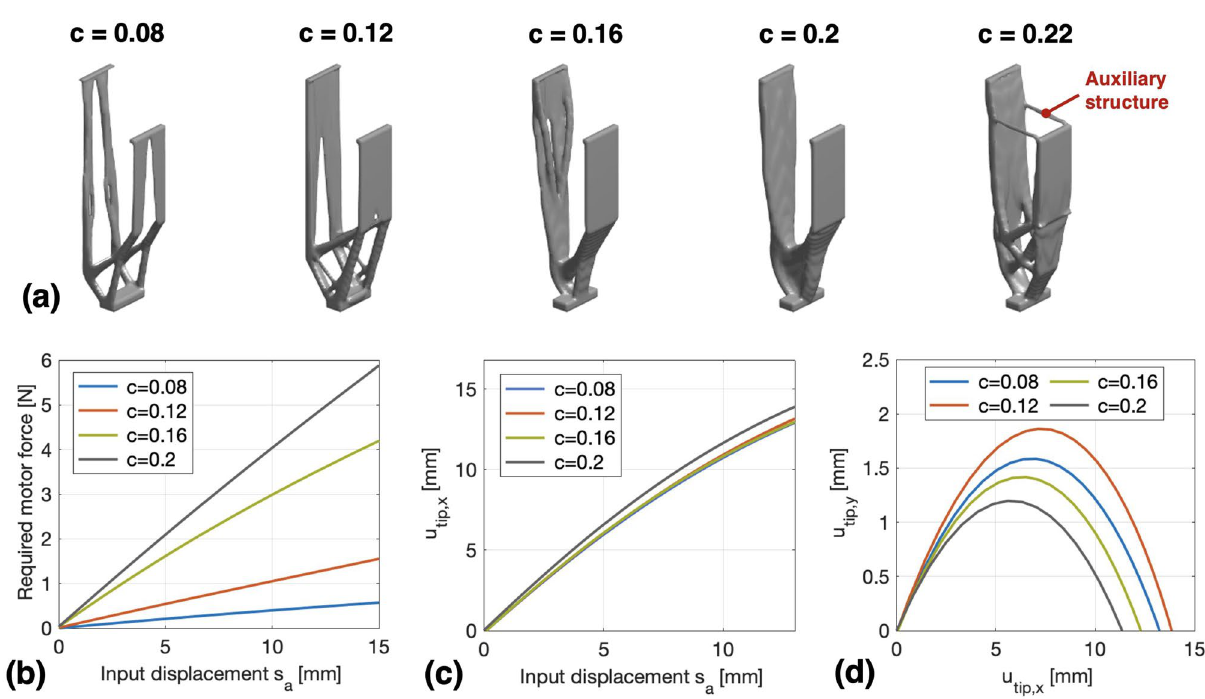
Figure 5. Compliant legs synthesized by using different volume constraints c : ( a ) The optimized leg shapes, ( b ) FEM-calculated actuation force (in N) for the realized legs, ( c ) FEM-calculated relationship between s a and the induced u tip , x for the realized legs, ( d ) FEM-calculated relationship between u tip , x and u tip , y during the two-stage bending motion of the